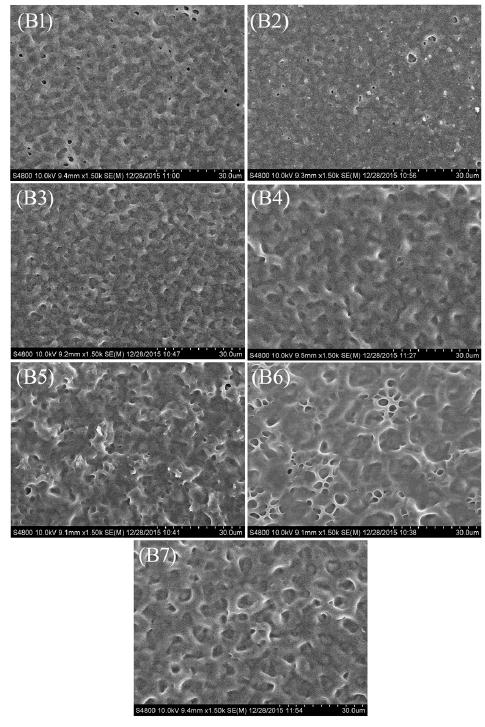
Figure 3. SEM micrographs of the polymer networks of the samples B1 – B7 .